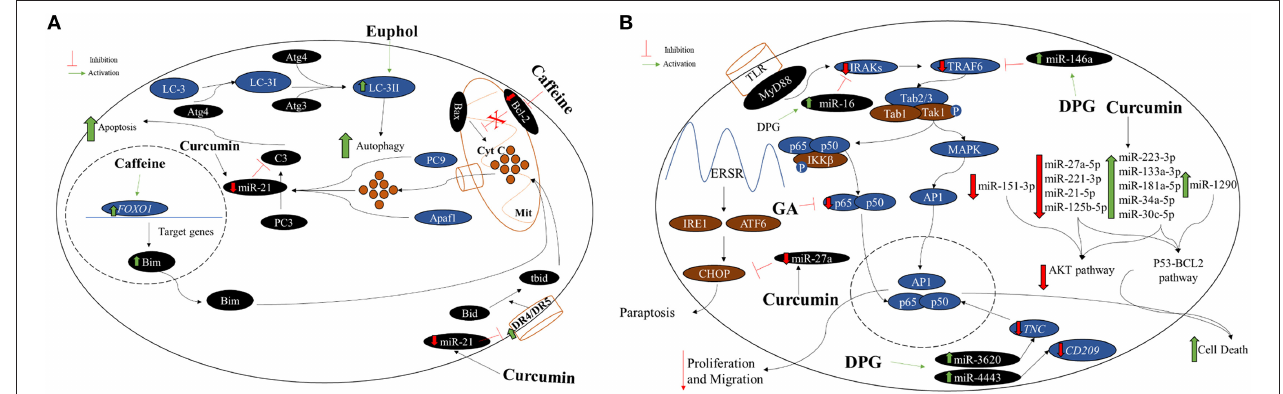
FIGURE 3 | (A) Caffeine, curcumin, and euphol antitumoral effect on GBM cell lines. Generally, the mitochondrial apoptotic pathway is regulated by the proapoptotic protein Bax, which acts in the dissociation of cytochrome C (Cyt C) in the mitochondria (Mit). Thus, Cyt C along the procaspase 9 (PC9) and Apaf1, activate procaspase 3 (PC3) into caspase 3 (C3) leading the cell to apoptosis. Moreover, the nuclear protein Foxo1 acts in the transcription of Bim, which contributes to the dissociation of Cyt C and apoptosis stimulation. Therefore, the ratio Bax/Bcl-2 is an excellent indicative of cellular apoptosis. Caffeine acts decreasing BCL-2 and increasing FOXO1 expression levels causing greater apoptotic activity. Curcumin can inhibit miR-21 expression and consequently activating apoptosis by caspase 3 and death receptor (DR) 4 and 5 activations. Autophagy, a misfolded proteins degradation and elimination and also damaged organelles, is control by the LC-3 protein that interacts with Atg family for the LC3-II formation and autophagy activation. Euphol is able to enhance LC3-II levels direct in GBM cell lines. (B) Effects of GA, DPG, and curcumin on apoptosis, migration, and paraptosis in GBM cell lines. GA, a compound isolated from licorice root, has presented inhibition effect on cell proliferation and colony formation in U251 GBM cell line. In addition, GA also presented apoptosis stimulation in these cells. The GA antitumoral effect is by direct p65 protein inhibition, responsible for nuclear factor kappa B (NF- κ B) pathway activating. More recently, DPG, a dipotassium salt of GA, also has presented antitumoral effect related to NF- κ B pathway suppression by IRAK2 and TRAF6 -mediating miR-16 and miR-146a, respectively, in U87MG and T98G cells. More recently, it was observed that DPG upregulated miR-4443 and miR-3620, responsible for post-transcriptional inhibition of the NF- κ B pathway by CD209 and TNC modulation, respectively, in U251 and U138MG, leading to lower MMP-9. The curcumin effect was able to increase miR-223-3p, miR-133a-3p, miR-181a-5p, miR-34a-5p, miR-30c-5p, and miR-1290 expression leading to serine or threonine kinase pathway (AKT) pathway impairment. Curcumin effect also decreased miR-27a-5p, miR-221-3p, miR-21-5p, miR-125b-5p, and miR-151-3p expression causing p53-BCL2 pathway inhibition and consequently, GBM cell death. Interestingly, lower expression of miR-27a by curcumin action enhanced the CHOP protein expression, leading to